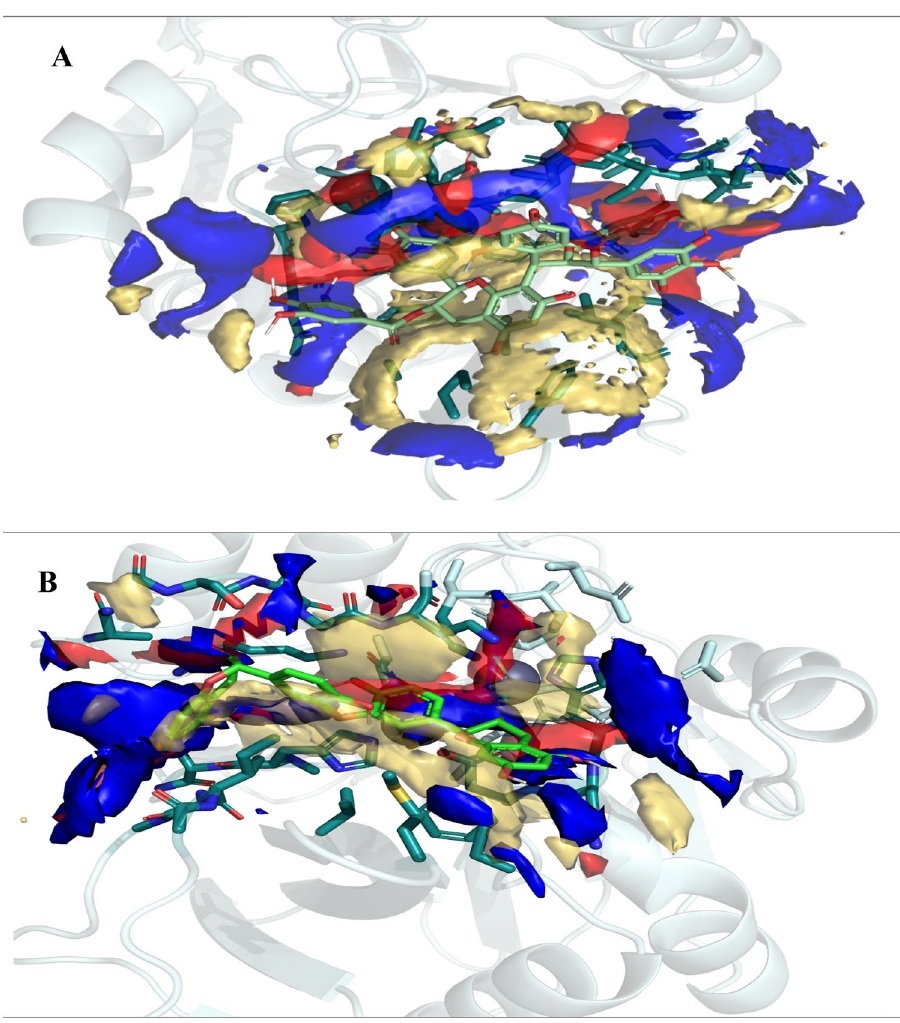
Figure 5. A-GRID MIFs of complex NDM-NPC100251 B- GRID MIFs of complex NDM- NPC171932. GRID MIFs were used for probes O (red, − 3.5 kcal), N1 (blue, − 3.5 kcal), DRY (brown, − 0.5 kcal). Values of 0.0 kcal/ mol to < − 2.5 kcal/mol tend to show the non-polar interactions, values of > − 2.5 kcal/mol tend to indicate hydrogen bonding is occurring, a and more negative values start to illustrate stronger charge interactions. Most ligand functional groups are associated in the O or N GRID MIF with 3.5 kcal/mol in the picture. Aromatic rings engaged in the DRY and CRY with 0.5 kcal/mol MIF. Some of oxygen in the ligand hydroxyl group had electrostatic contacts with Zinc ions. ΔΔ G binding = ΔΔG hydrogen bond + ΔΔG hydrophobic + ΔΔG vdw + ΔΔG electrostatic. It seems like the high number of the hydrogen bond, very low-value energy of the hydrophobic bond, van der Waals (near to hydrogen bond energy level) made those docking